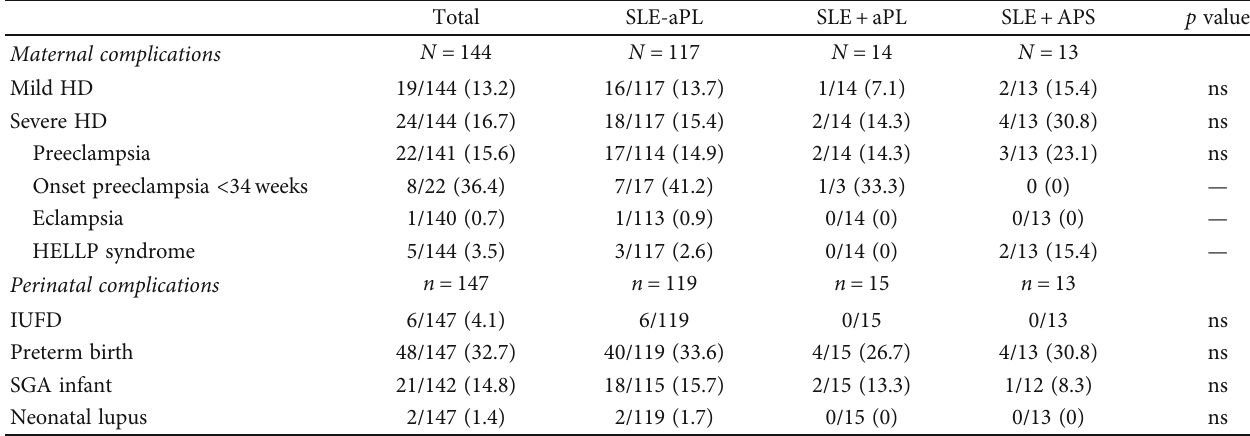
Table 3: Maternal and perinatal pregnancy complications in all study